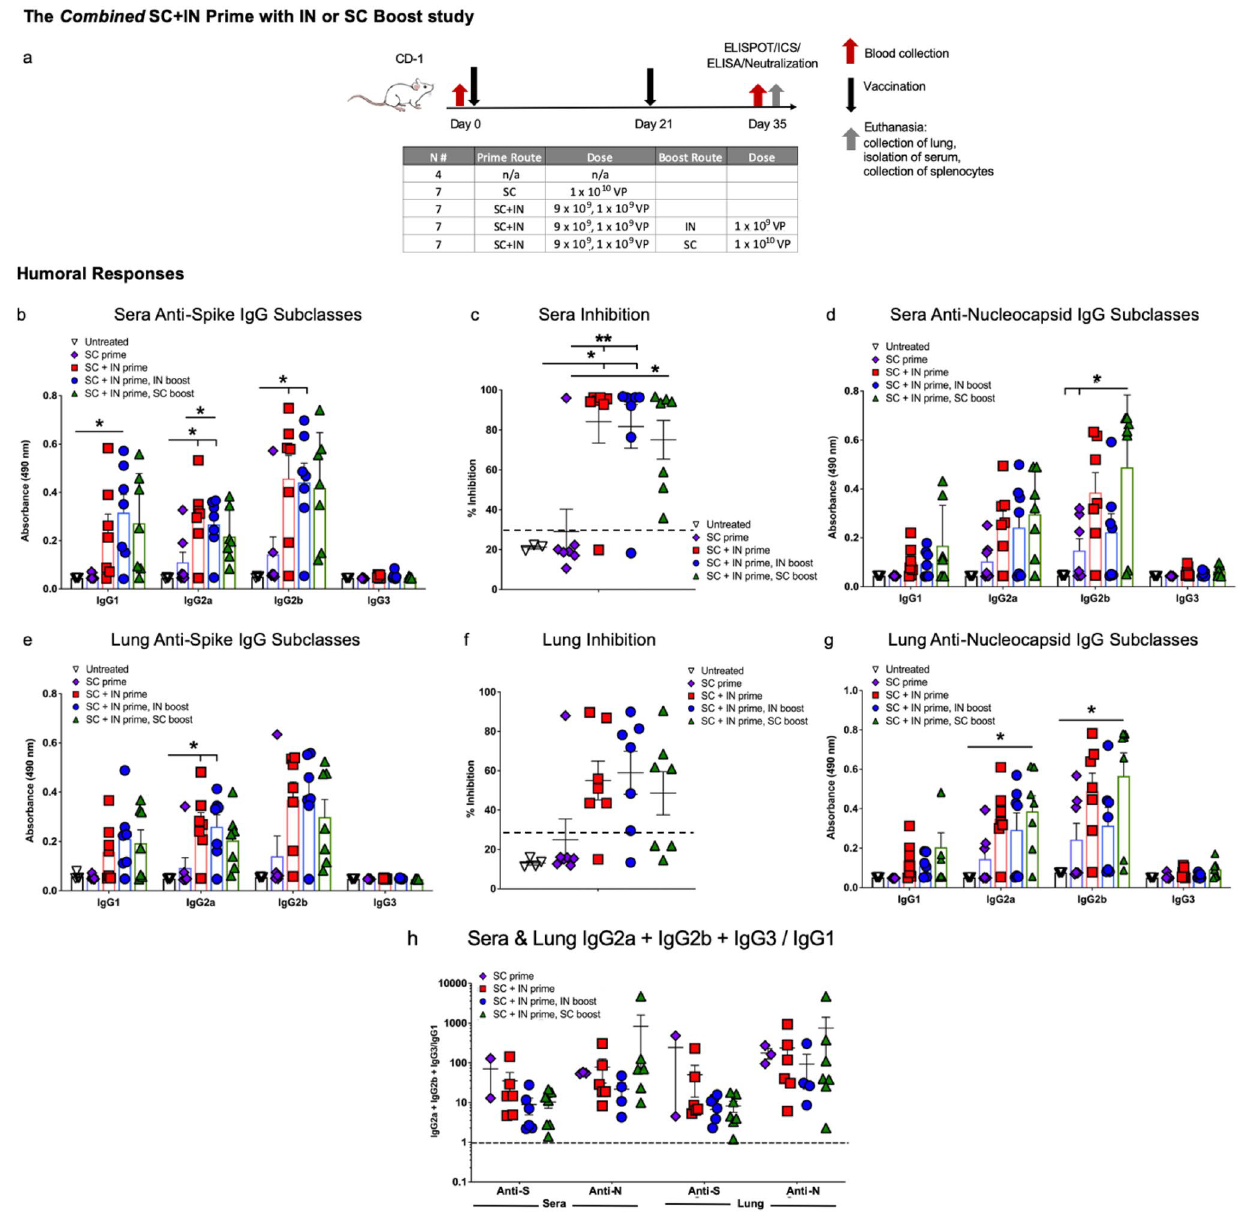
Figure 6. Subcutaneous (SC) plus intranasal (IN) prime without boost elicits Th1 biased neutralizing anti‑S and anti‑N antibodies. ( a ) The study design is shown with groups for SC prime only, SC + IN prime only, and SC + IN prime with either an SC or IN boost, all n = 7. There was an untreated control group of n = 4. Prime dosing was on Day 0, boosts on Day 21, and euthanasia on Day 35. Shown are sera ( b ) anti-spike (S) antibodies by subclass (dilution 1:30); ( c ) percent inhibition in the surrogate neutralization assay with sera where > 30% (dashed line) is correlated with neutralization of virus; and ( d ) anti-nucleocapsid (N) antibodies (dilution 1:270). Lung homogenate ( e ) anti-S antibodies; (f) neutralization (30% is dashed line); and ( g ) anti-N antibodies (dilution 1:30 for anti-S and -N). ( h ) The IgG1a + IgG2b + IgG3/IgG1 ratios for anti-S and anti-N antibodies are shown for sera and lung; values > 1 (dashed line) indicate Th1 bias. The ratio is not represented for mice with very low antibody production. Statistical analyses performed using One-way ANOVA with Tukey’s post-hoc analysis comparing groups where * p < 0.05 and ** p ≤ 0.01. Data graphed as the mean with